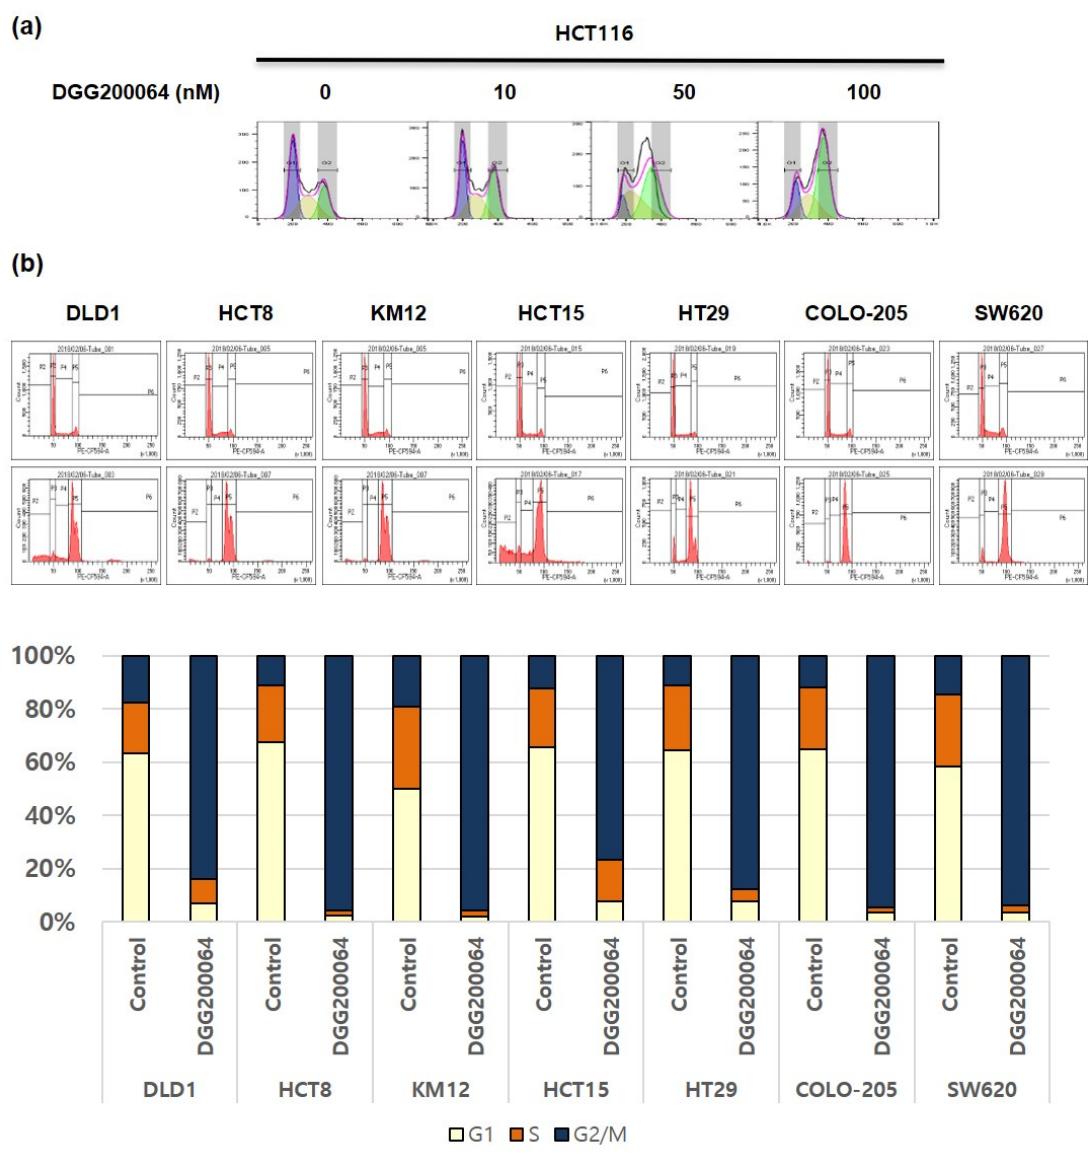
Figure 2. FACS analysis of the induced G2/M cell cycle arrest by DGG200064: ( a ) The DGG200064 induced G2/M cell cycle arrest in HCT116 cells in a dose-dependent manner for 6 h; ( b ) Various colon cancer cells treated with DGG200064 (50 nM) for 6 h.